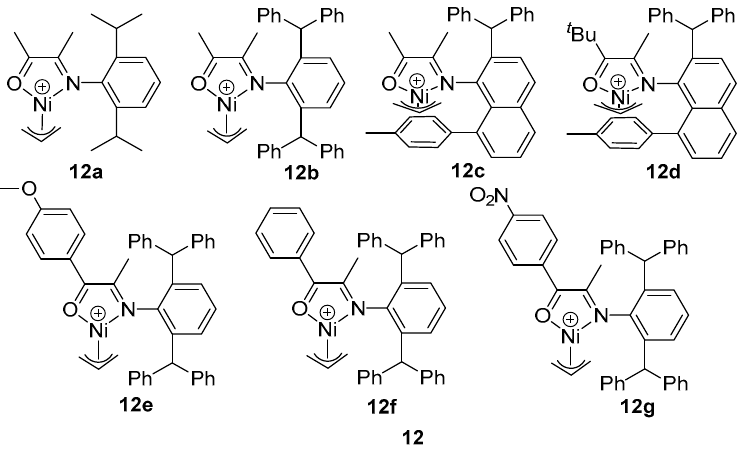
Figure 10. Single-component cationic α -ketiminato nickel catalysts 12a – g .